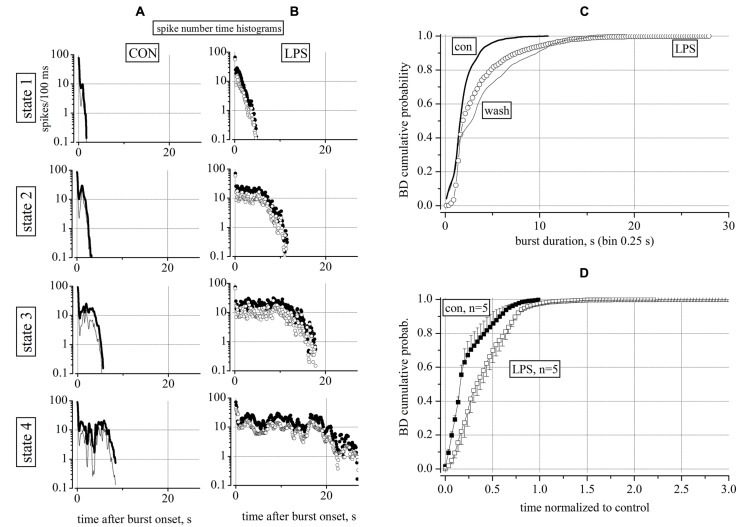
Characterization of reverberating activity recorded in control and 4 h after application of 3 μg/ml LPS. Data (time segments of 2 h) in (A,B) show global firing properties during control (CON) and 4 h after application of LPS. (A,B) Plots of spike number time histograms (SNTH, spike number/0.1 s bin width: log-scale vs. time after burst onset in seconds) representing properties of bursts classified into four states from up to down. In control and in LPS (in parentheses) the number of events assigned to states 1, 2, 3, and 4 were: 122 (280), 255 (50), 66 (20), and 15 (6). LPS therefore strongly modified the pattern of the burst durations by favoring the large (>10 s) durations in 21% of the bursts as compared to control where all of the durations were below 10 s as shown in detail below in Figure 3. (C) Superimposed BD cumulative probability plots during control (5 h, thick line), 3 μg/ml LPS (6 h, open circles) and after washout (4 h, thin line). Data from an experiment with 65 excitatory and 26 inhibitory neurons (classified as described in Section “Materials and Methods”) respectively. Number of analyzed bursts were 1208 in control, 1421 in LPS and 634 in washout respectively. The non-parametric Kruskal–Wallis statistical significance method gave, for the pairs con/LPS, LPS/wash and con/wash, the following results: P < 0.0001, P < 0.029, P < 0.0001, respectively. (D) Cumulative probability of BD averaged from 5 similar experiments done in different dishes after correctly normalizing the control part of each experiment for having a value of 1 and 60 equally spaced bins (error bars are ±SEM). Note that the LPS action on BD distribution was consistently different with respect to control; also for LPS data, after normalization, the time scale had a maximum value three times longer than for control data.